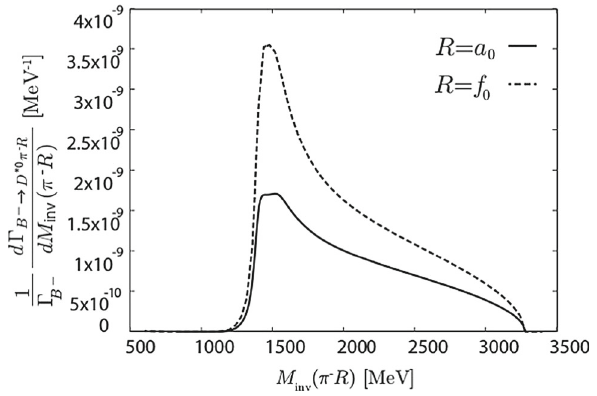
Fig. 7 The mass distribution of B − → D ∗ 0 π − π 0 η ( full line ) and B − → D ∗ 0 π − π + π − ( dashed line )